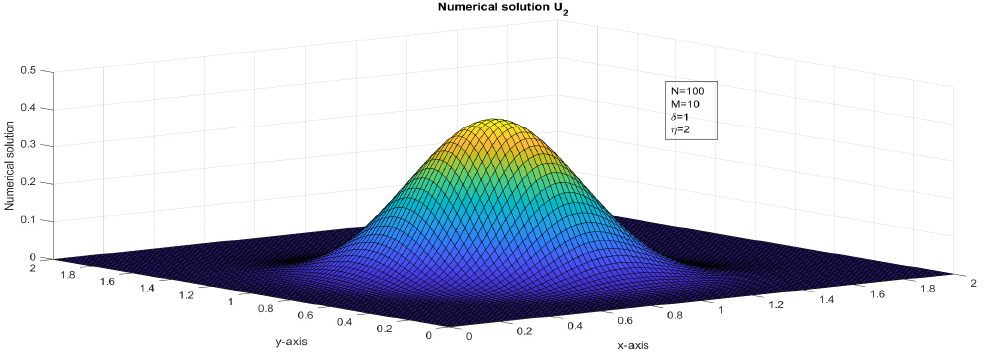
Figure 5. The surface plot illustrates the numerical solution, U 1 , for Case 3 in Example 1.